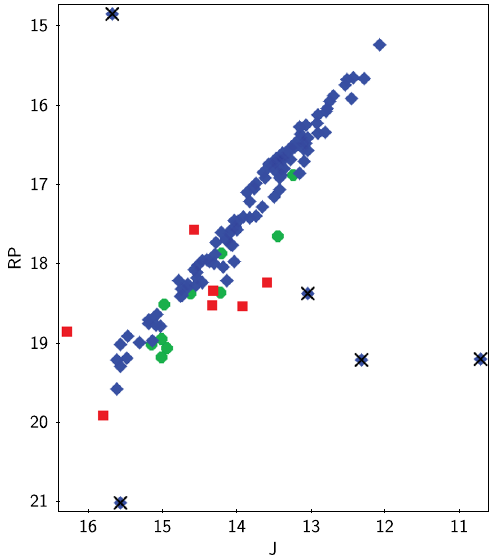
Figure 8: Magnitude – magnitude